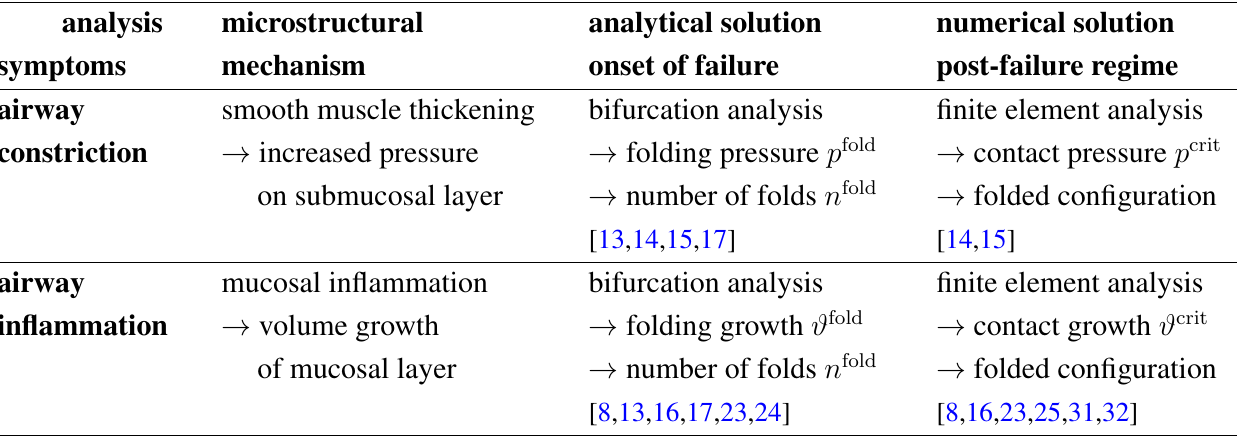
Table 1. Classification of existing models of chronic lung